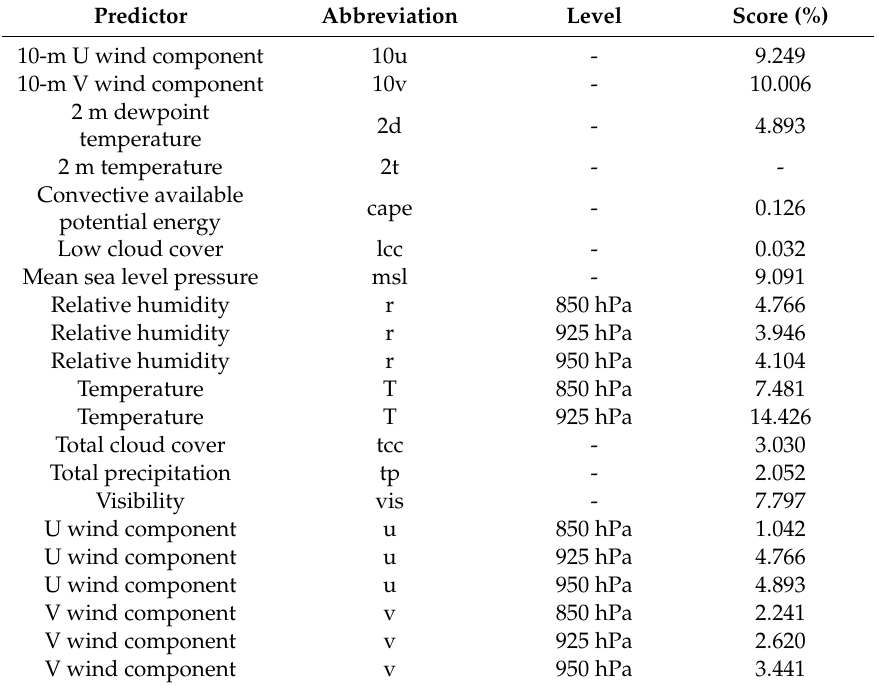
Table 2. Weather elements, abbreviations, and